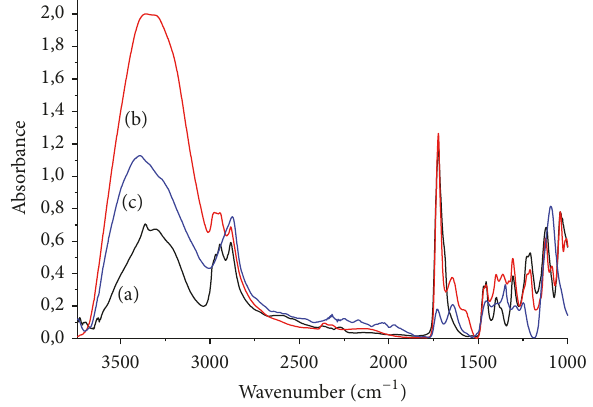
Figure 7: FT-IR spectra of HBP \ BH20 (a), b oNPs (12 :1) (b), and b oNPs (16:1) ( c ).